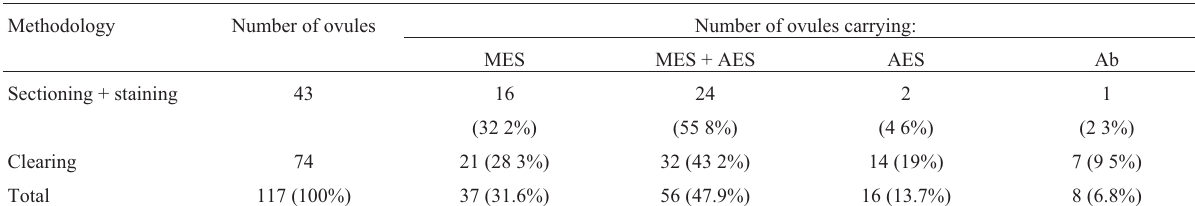
Table 3 - Type and numbers of female gametophytes observed in ovules from different tetraploid genotypes of Paspalum modestum.